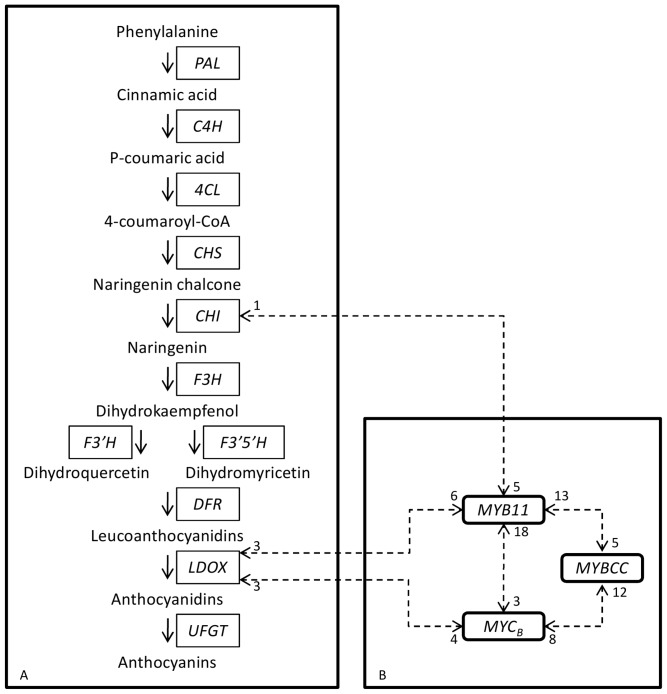
Schematic representation of the genes showing SNP×SNP statistical interactions.Scheme A shows a simplified biosynthetic pathway of anthocyanins. Scheme B shows the genes encoding transcription factors with SNPs (>25%) involved in SNP×SNP statistical interactions (P<0.001). The interactions are represented by dashed arrows and the numbers beside the arrows indicate the number of SNPs involved in significant interactions.